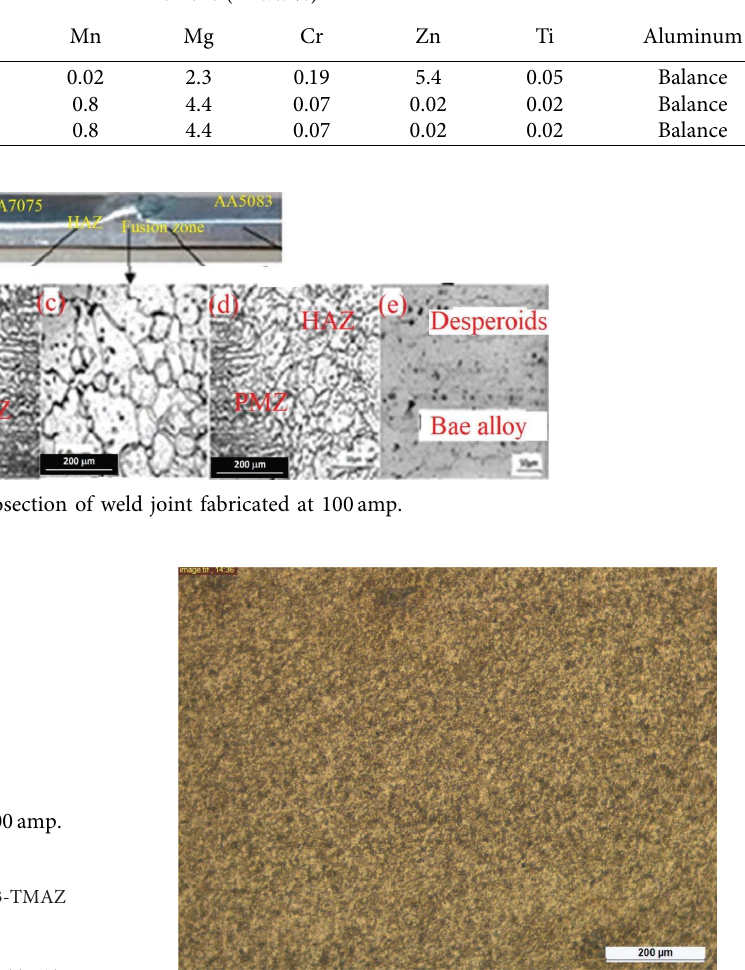
Figure 4: Stir zone microstructure of a weld joint fabricated at 1100rpm.